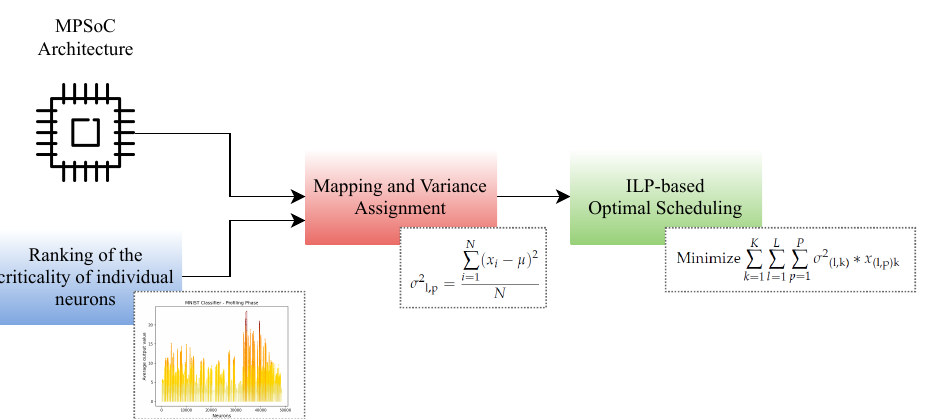
Figure 1. Proposed approach to improve the reliability of a neural computing system based on a